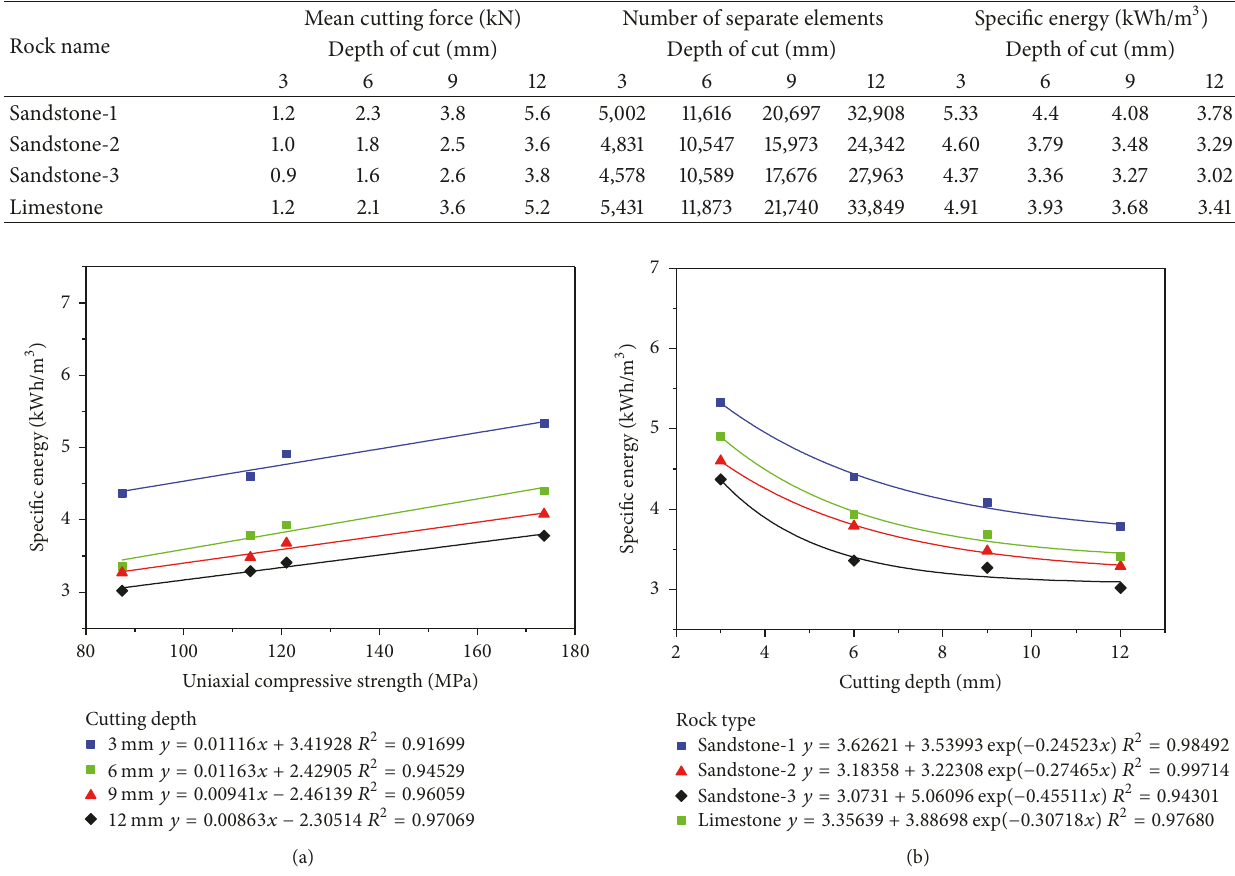
Figure12:Therelationshipbetweenthespecificenergyandrockmechanicalproperties:(a)thelinearfittingbetweentheuniaxialcompressive strength and specific energy and (b) the exponential fitting between the cutting depth and specific